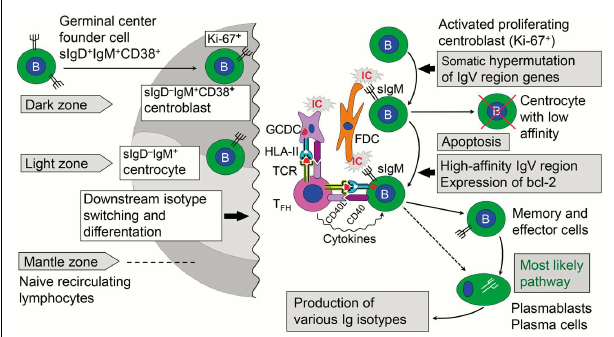
FIGURE 6 | Immune events taking place in the dark and light zones of human germinal center in secondary lymphoid follicle .The “germinal center founder cells” receive their initial stimulation through cognate interaction with activated CD4 + helperT cells just outside the lymphoid follicle before they enter it to become proliferating centroblasts forming the dark zone. Affinity maturation of sIgM as part of the B-cell receptor is achieved after somatic hypermutation by competition for antigen presented in ICs on FDCs. Antigen taken up by the B cells is further presented in a cognate fashion toT FH cells, which also receive stimulatory signals from GCDCs.The activatedT FH cells act on the B cells with their cytokines, thereby mediating expansion of high-affinity B-cell clones in the light zone. Further details are discussed in the text. sIg, surface immunoglobulin; bcl-2, anti-apoptotic B-cell lymphoma protein; IC, immune complex; FDC, follicular dendritic cell; GCDC, germinal center dendritic cell; HLA-II, HLA class II